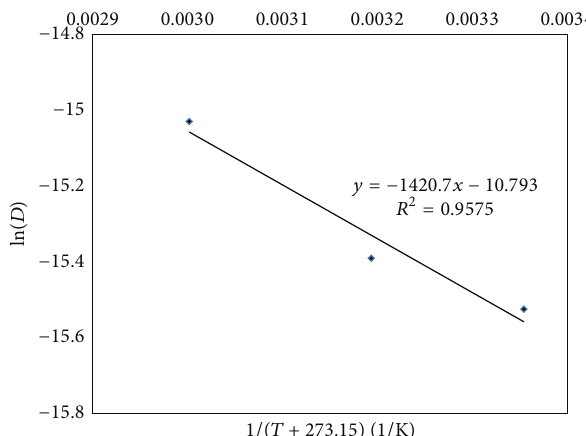
Figure 5: Arrhenius-type relationship between effective diffusivity coefficient and temperature.